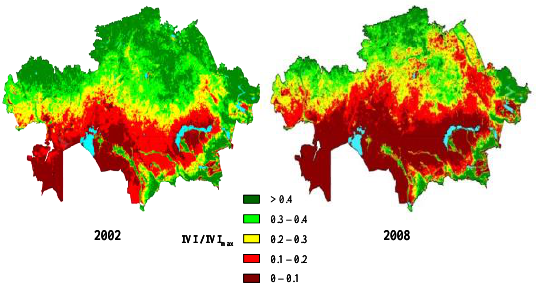
Figure 2. Zones of different vegetation productivity Long-term dynamics of areas of zones with different vegetation productivity is shown in Figure 3. Negative trend is marked for areas of high productivity zones, long-term changes in the areas of low productivity zones have tend to increase.